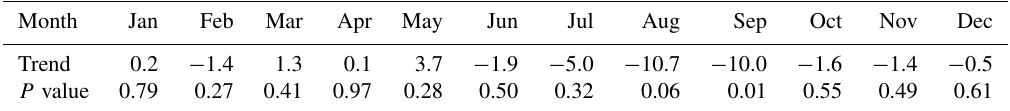
Table 1. The monthly precipitation trends (mmmonth − 1 decade − 1 ) in SWC during 1979 to 2013. The P values of the trends were calculated based on the two-tailed Student’s t test.